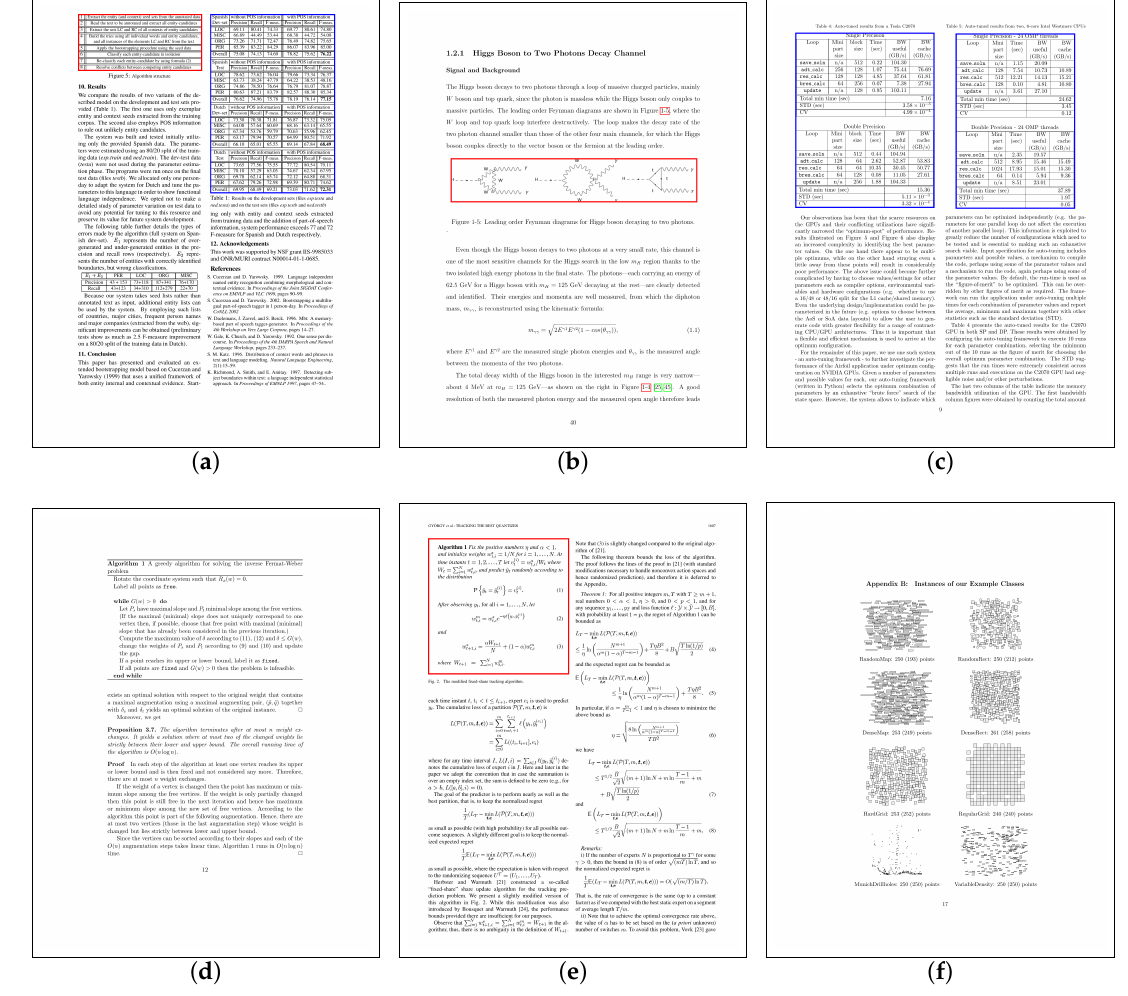
Figure 2. Some annotated examples from the CS-Large corpus [4]. Table annotations in blue, figure annotations in red. Subfigure ( a ) shows a document with three tables. One of them is annotated as